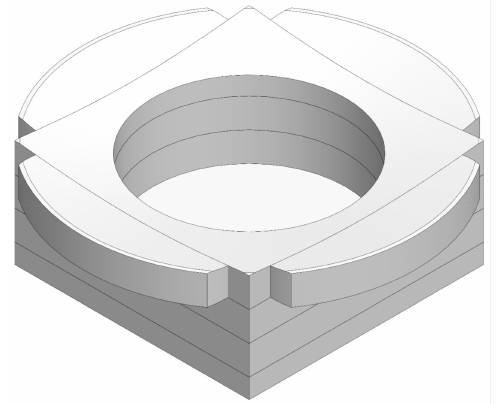
Figure 3. CAD model of water tank assembly. The lines represent the adhered and chemically sealed layers of expanded polystyrene